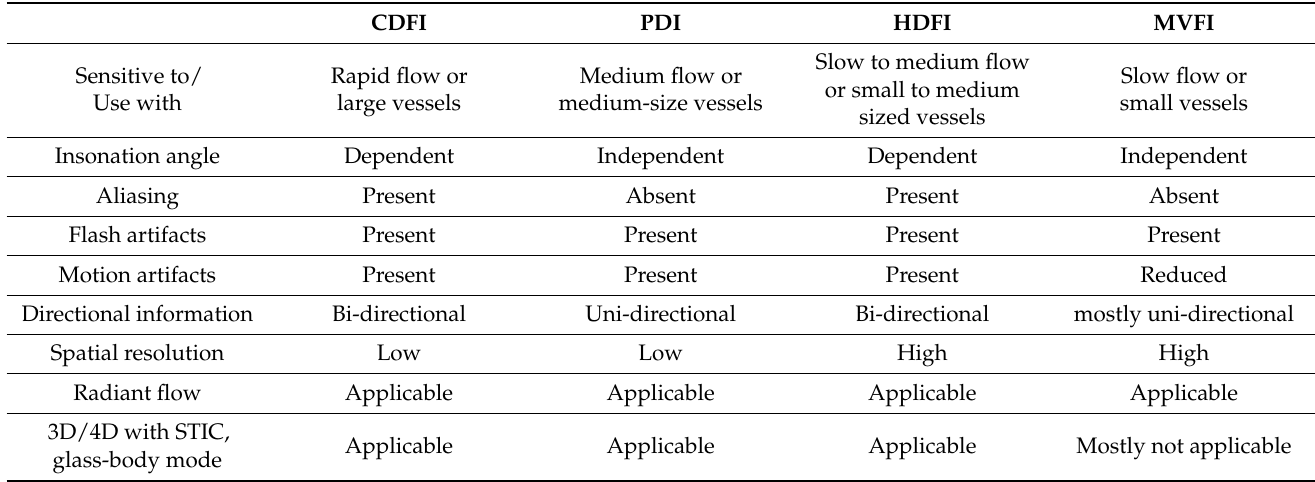
Table 1. Characteristics of different modes of color flow imaging.